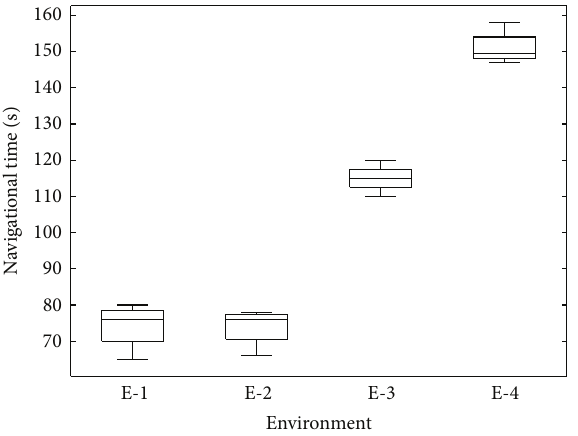
Figure 8: Box plot analysis for the navigational times by